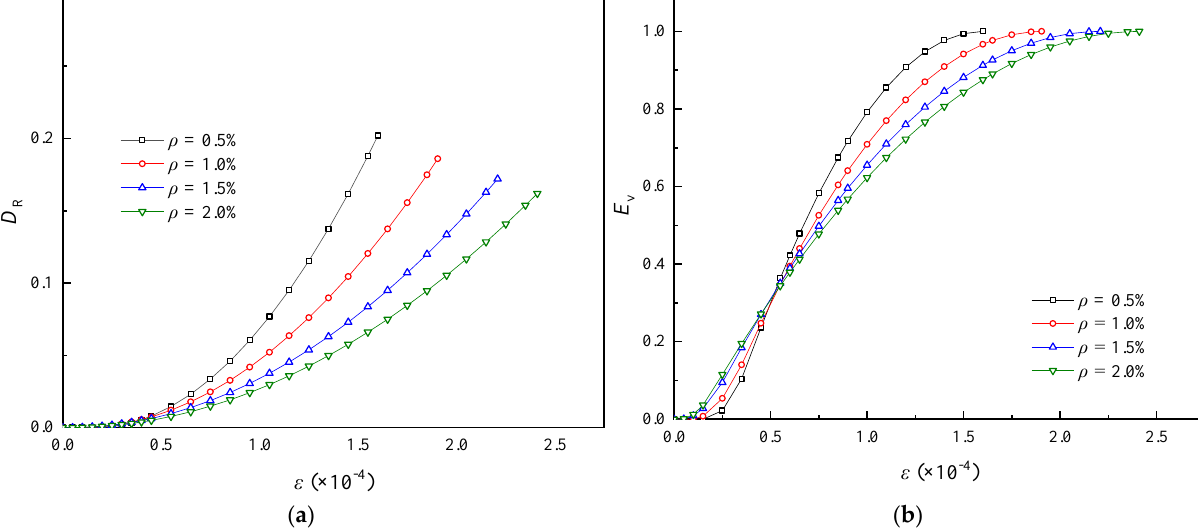
R - ε curves; ( b ) E v - ε